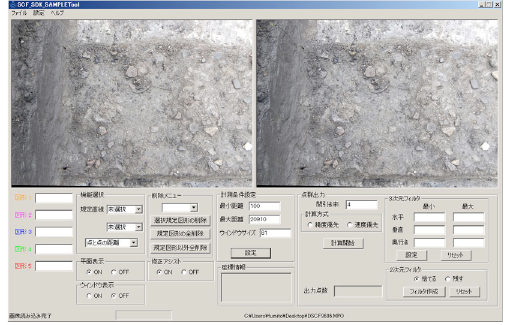
Figure 9. Developed software